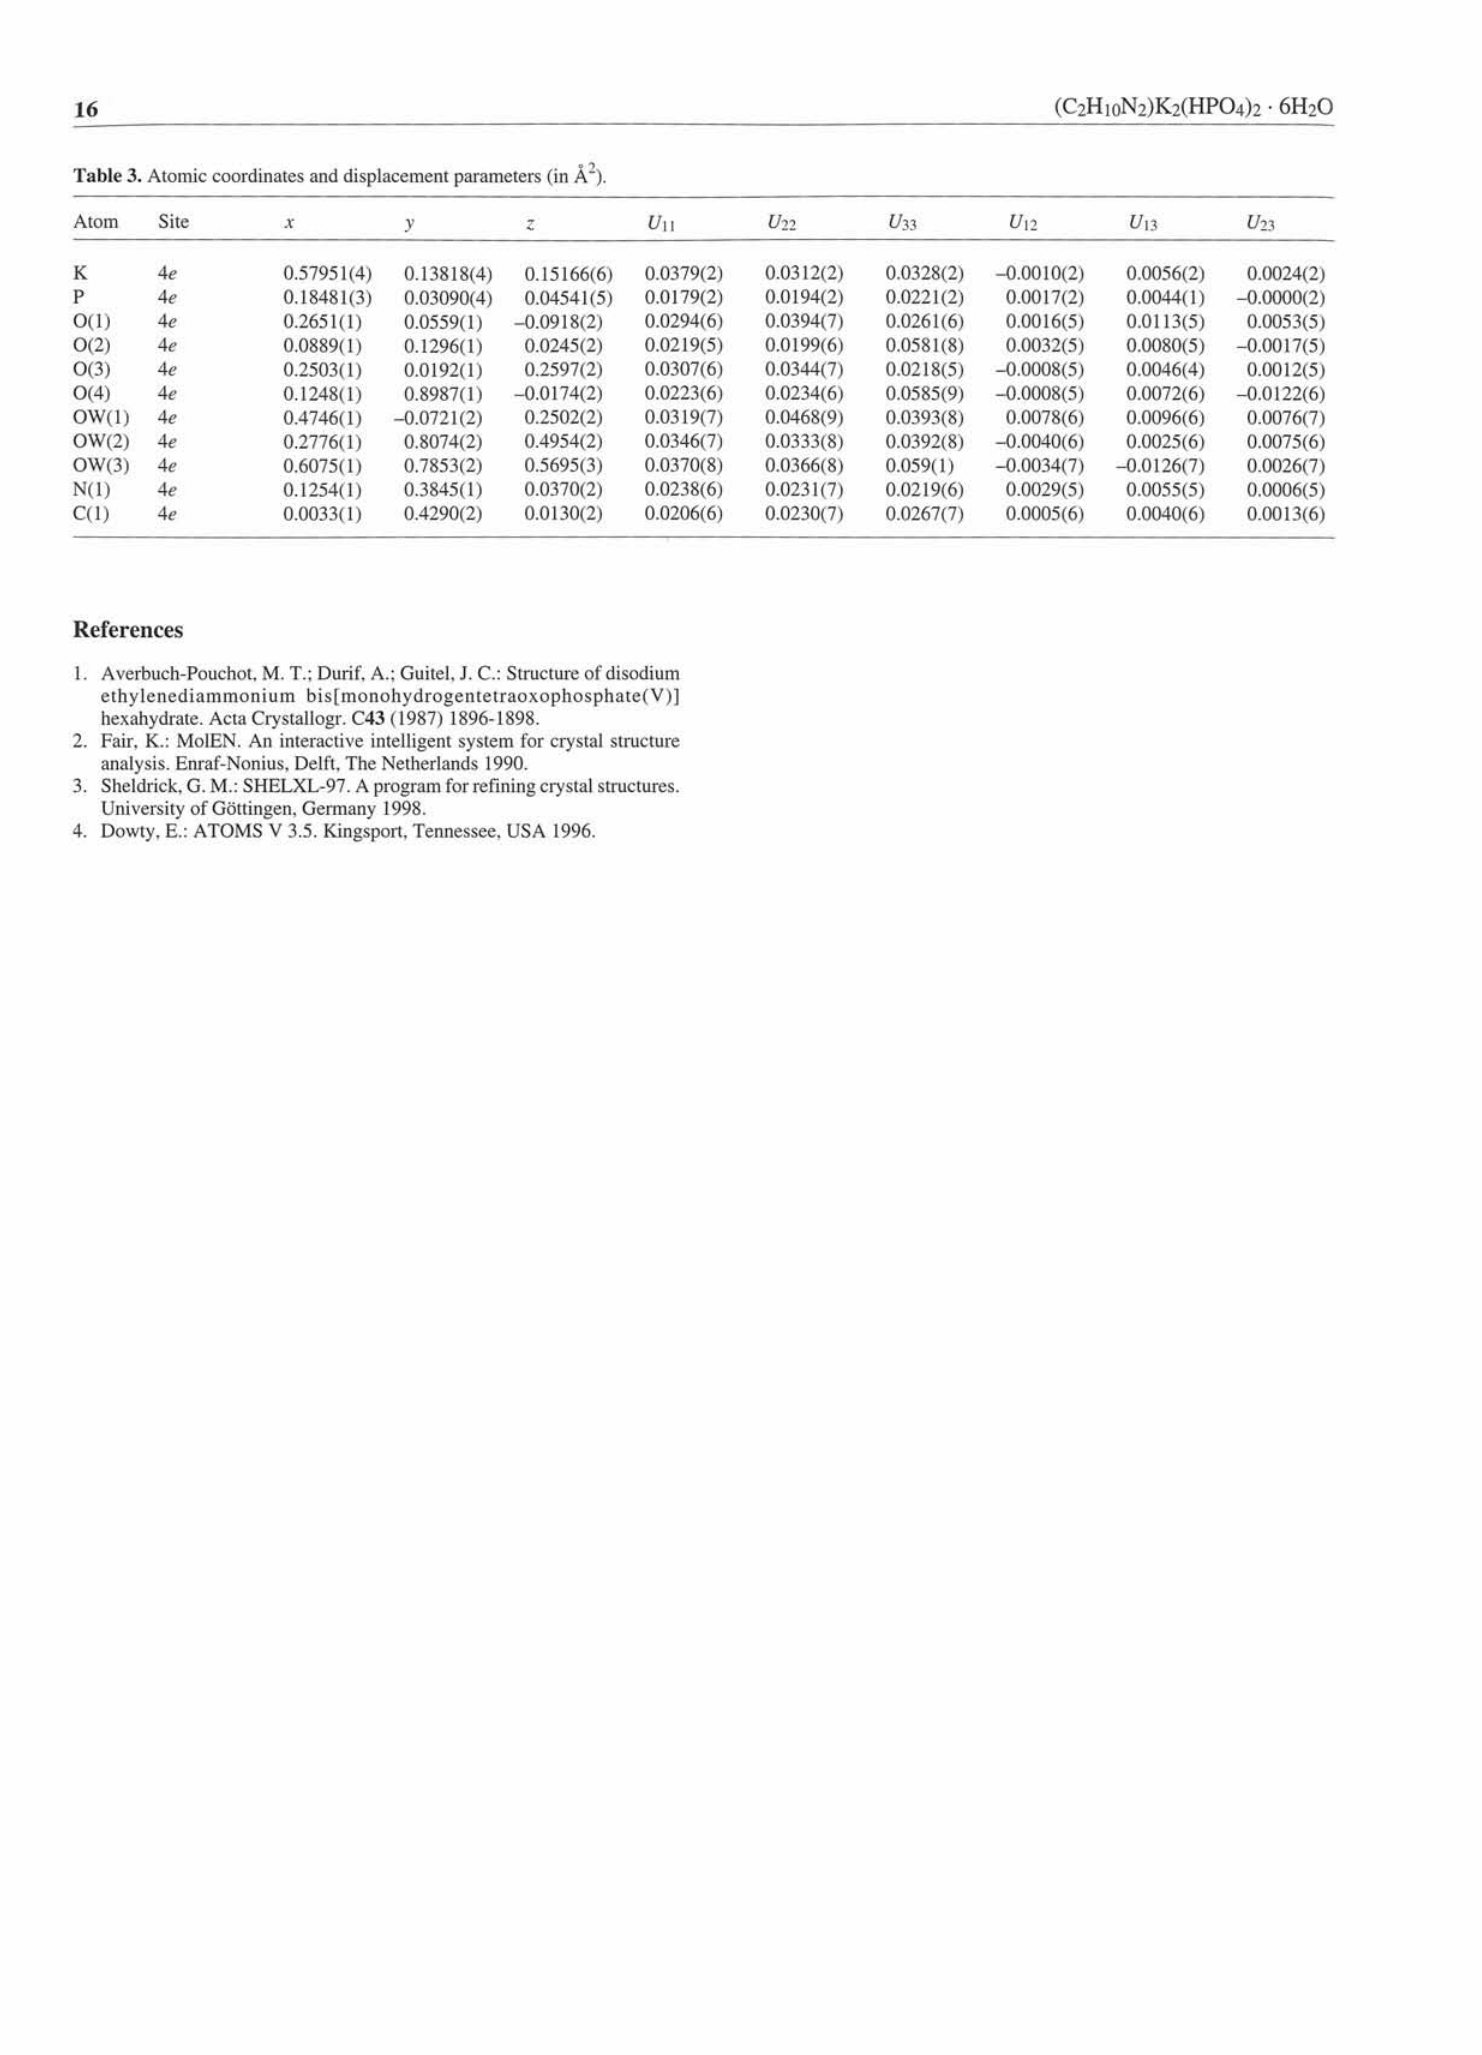
Table 3. Atomic coordinates and displacement parameters (in Â 2